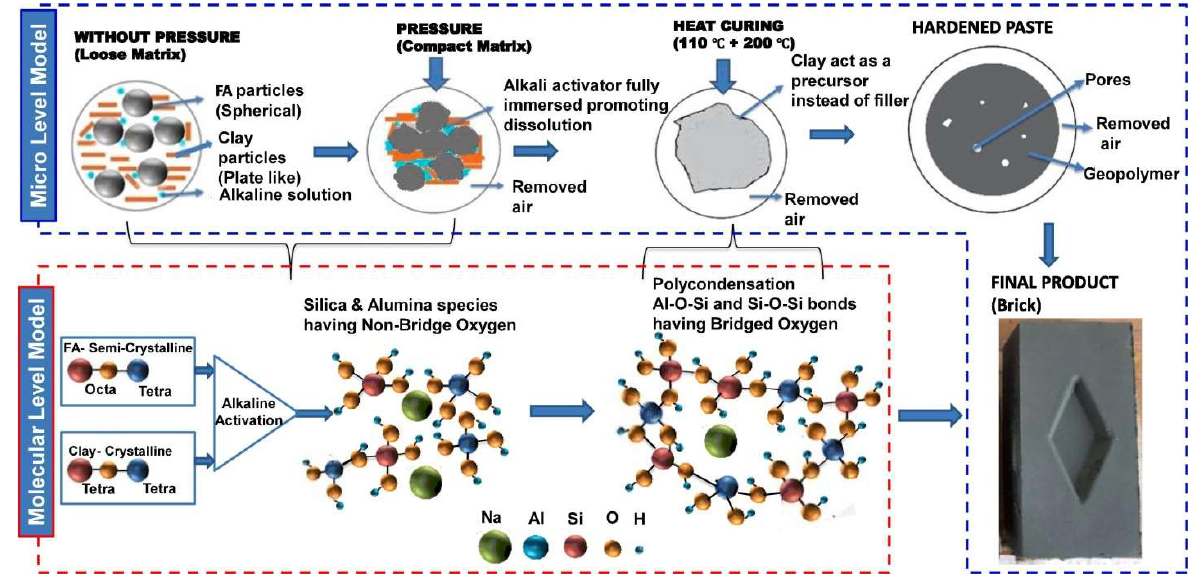
Figure 21. Strength gain mechanism at a micro and molecular level in bricks made from clay-based geopolymers [99].